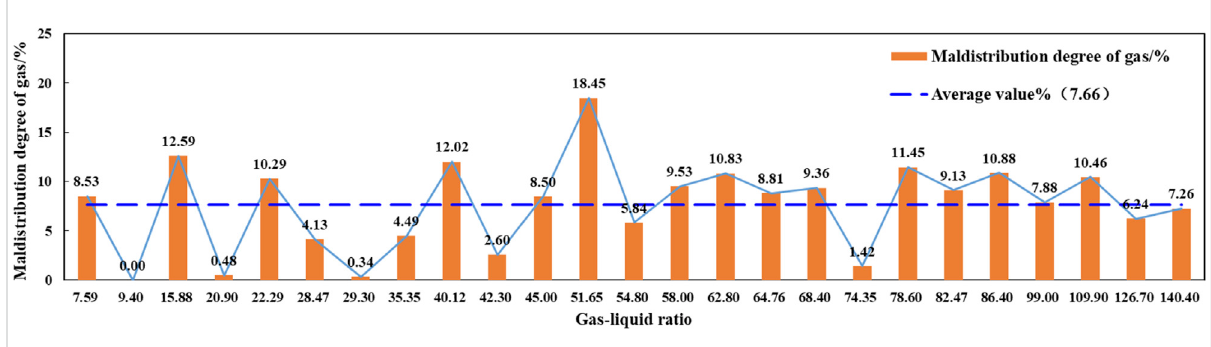
FIGURE 5 Histogram of gas – liquid ratio and maldistribution degree of gas in strati fi ed fl ow in horizontal manifold without fl ute pipes (liquid injection volume 0.10L/s+0.17L/s).